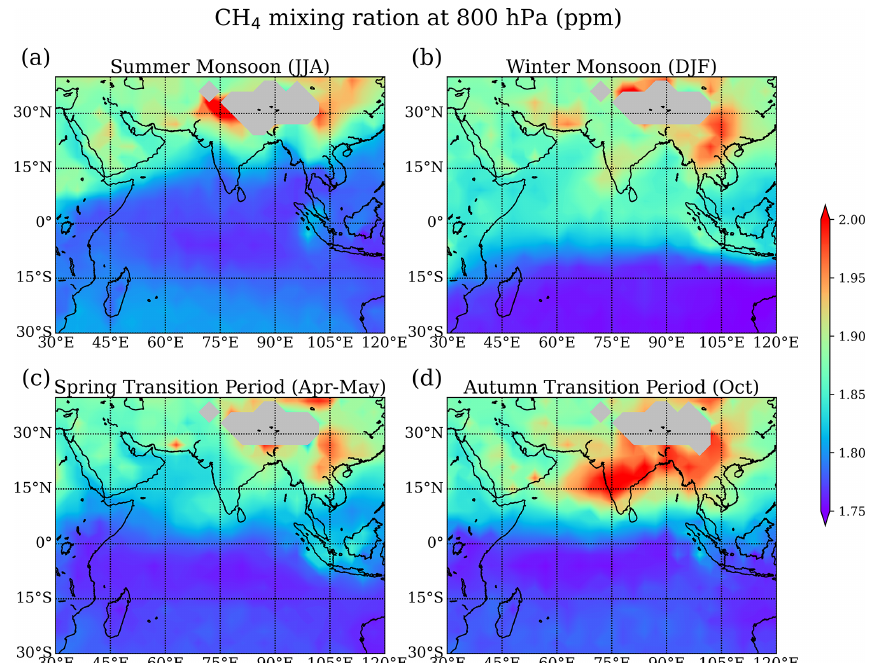
Figure 14. Methane (CH 4 ) mixing ratios at 800hPa from GOSAT for (a) summer monsoon 2009–2014 (June–August), (b) winter